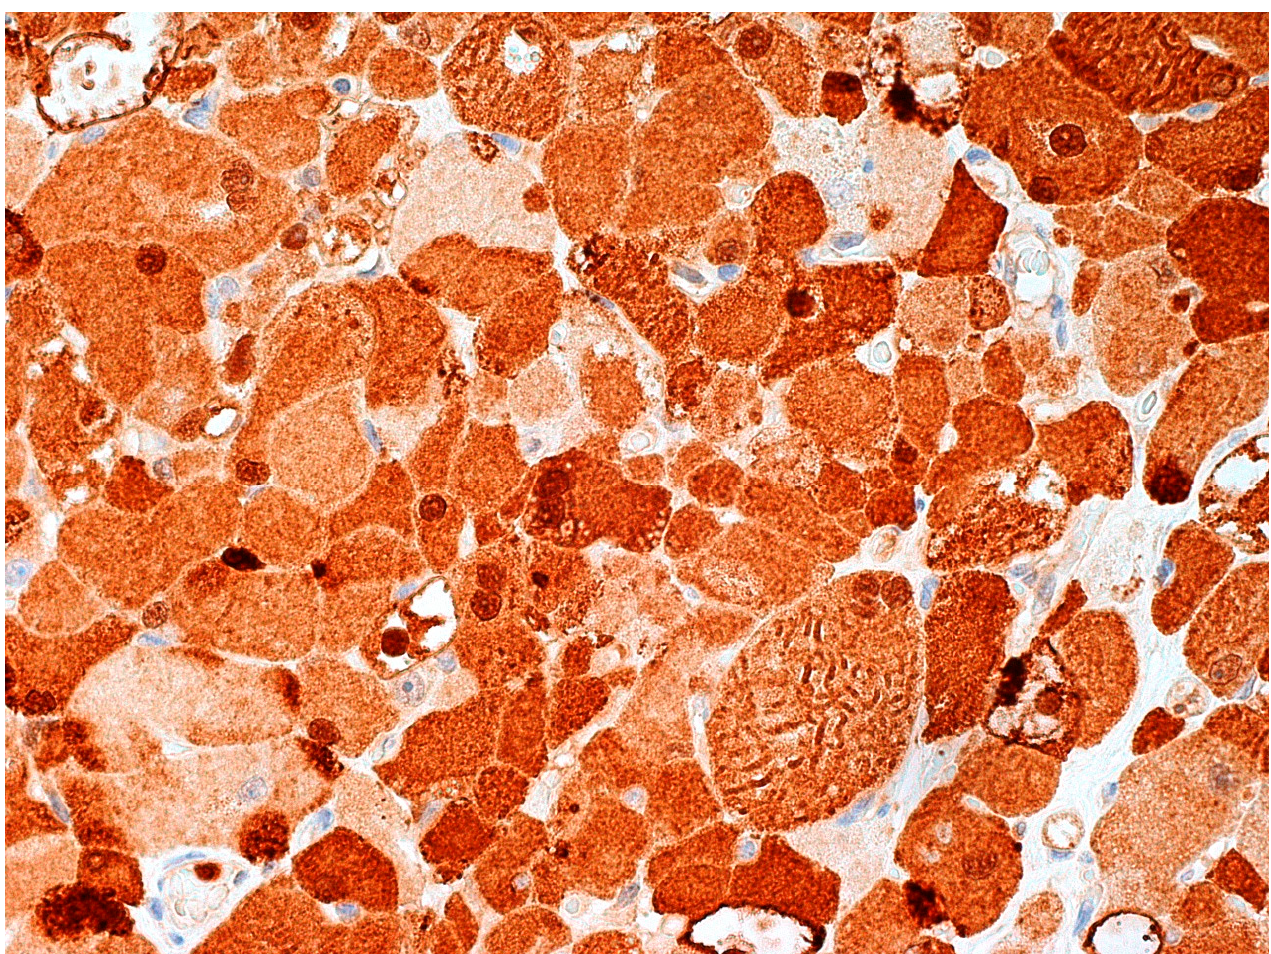
Figure 6. As the case had the morphological features of an adult-type rhabdomyoma (RM), previous slides were retrieved. Rod-like inclusions and cross striations were less evident and the material was fragmented; S-100 immunohistochemical expression was previously reported. Indeed, S-100 positivity was confirmed in >90% of tumor cells in our specimen, which showed a variable (weak to strong) intensity of cytoplasmic and nuclear staining (Figure 6; 10×; clone 4C4.9, mouse monoclonal, Ventana Medical Systems, Oro Valley, AZ, USA; previously unpublished, original photo).